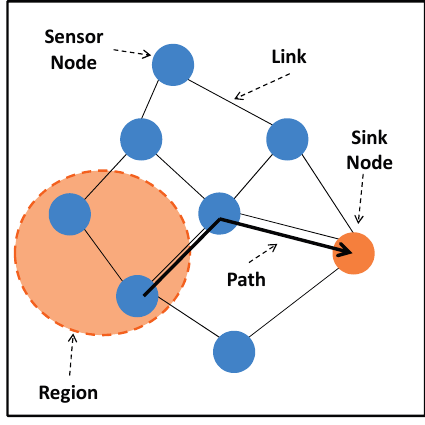
Figure 5. WSN Elements considered in the modeling